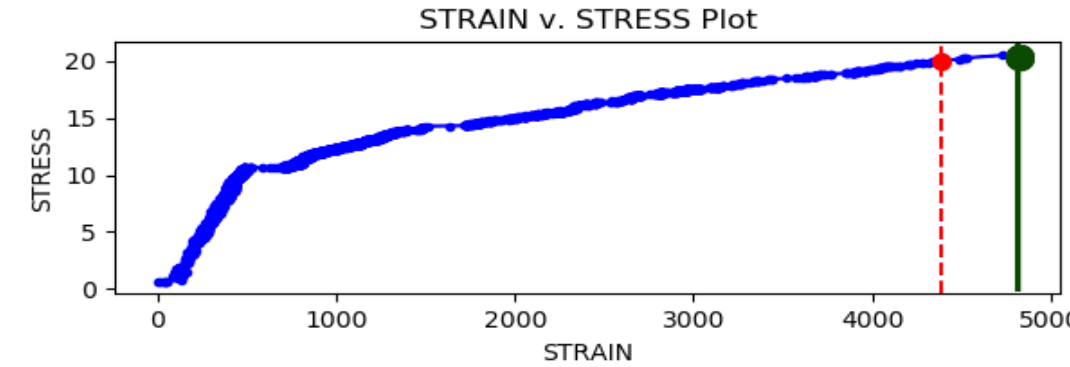
Figure 4. Strain vs. internal pressure (Ksi) plot from tube #1. In blue: all AE signals within the tube. In red: AE signal numbered 3280. In green: AE from breaking instance numbered 3286.